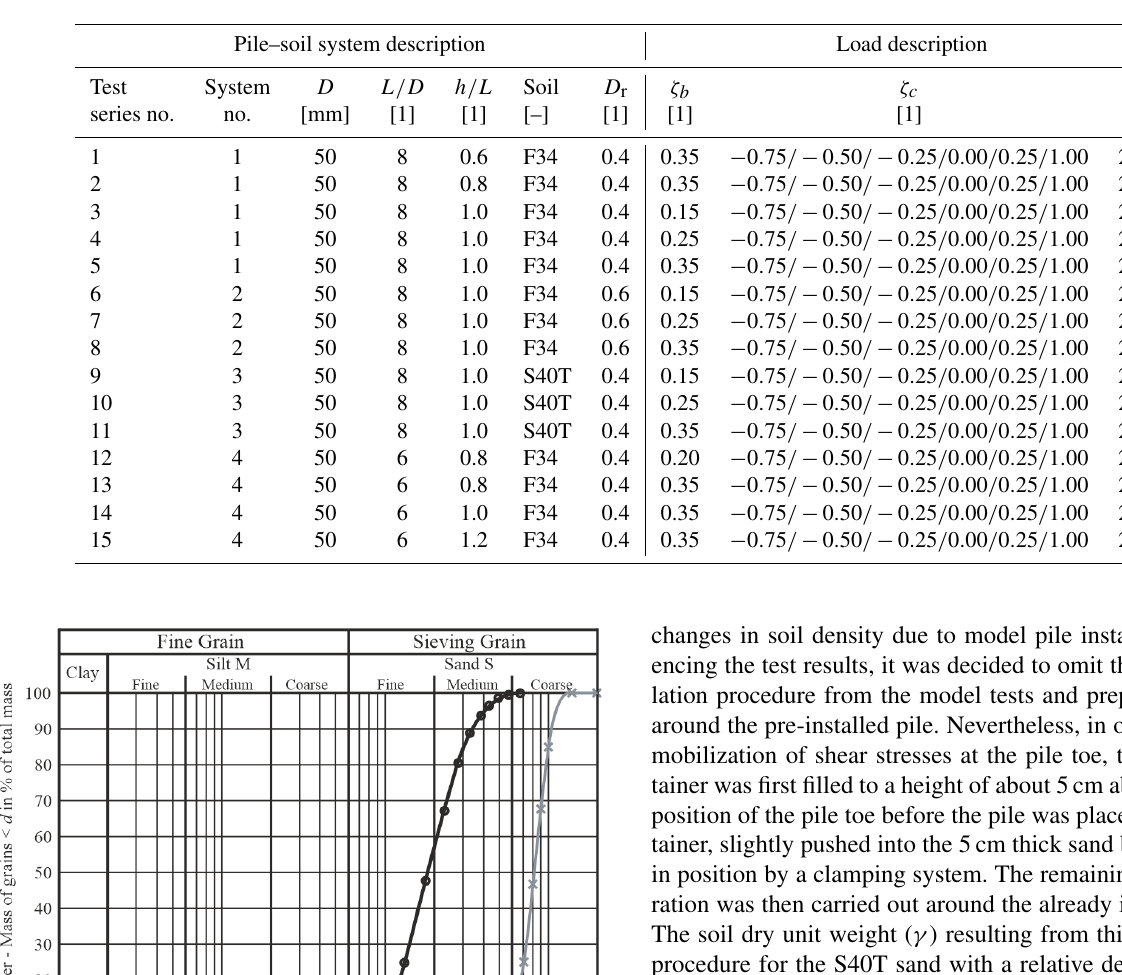
Table 3. Test program.